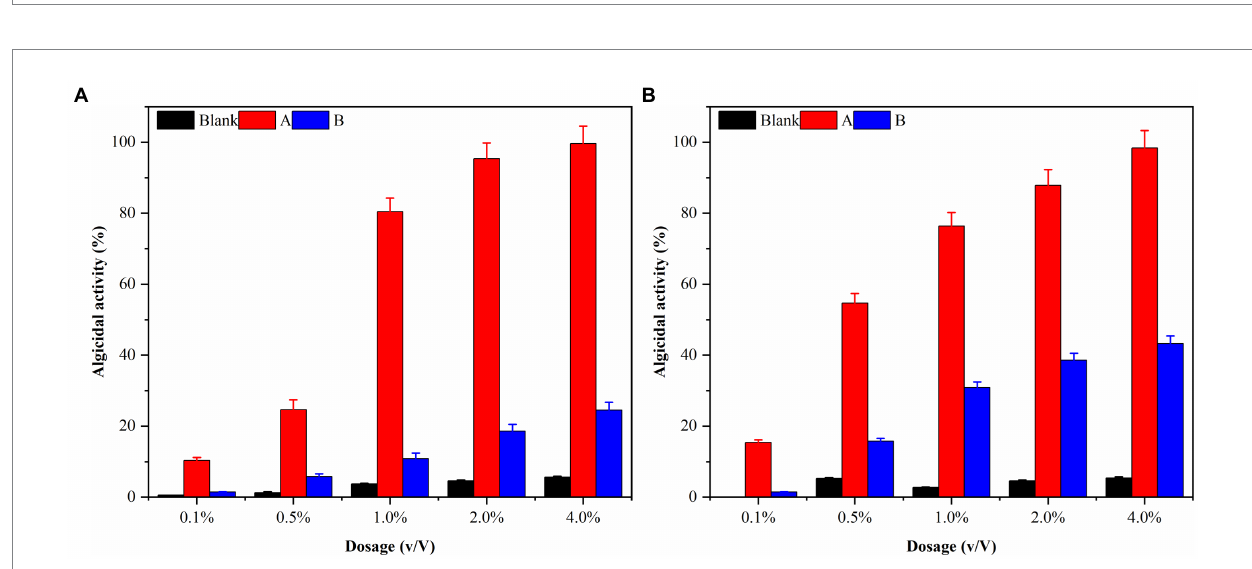
FIGURE 9 The algal lysis of G. catenatum (A) and K. mikimotoi (B) by ethyl acetate extraction phase (A) and residual phase (B) in fermentation broth of Pseudomonas sp.